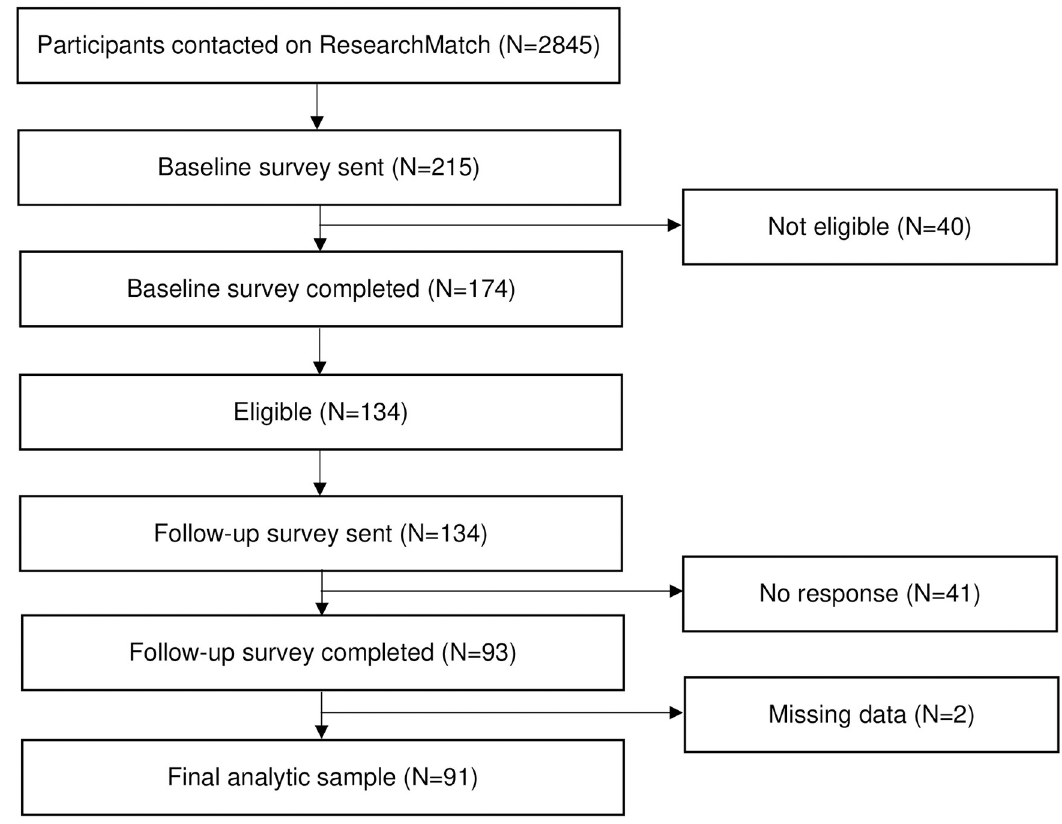
Fig 1. Flow chart of the recruitment process for study